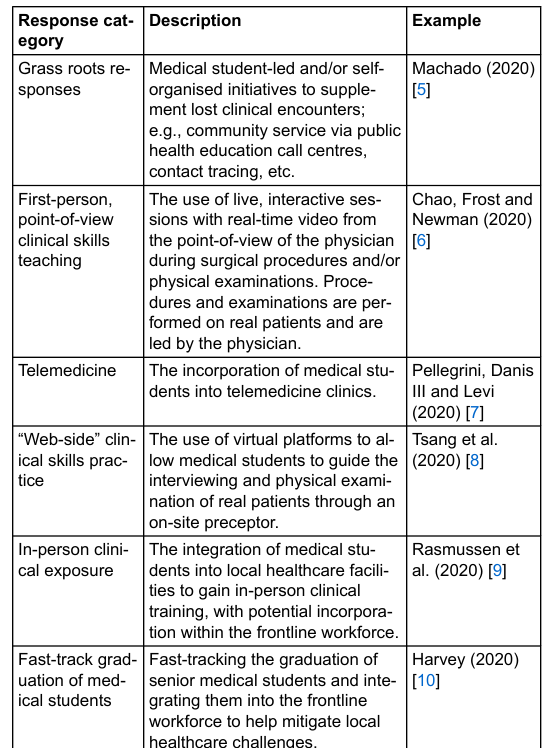
Table 1: Summary of medical education strategies used to reintegrate medical students into clinical learning environments during the COVID-19